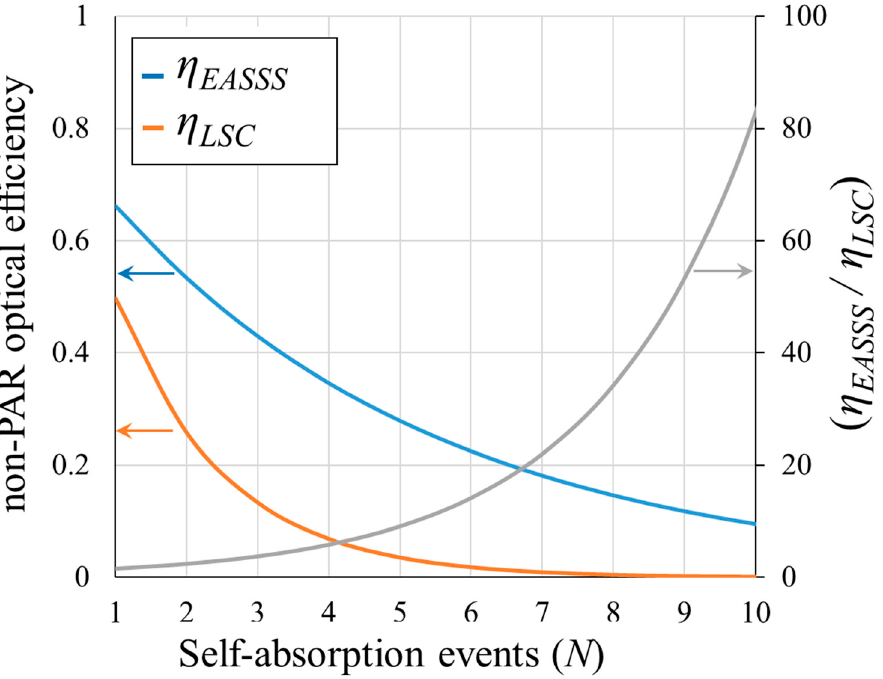
Figure 12. Optical efficiencies for both a conventional LSC and the EASSS panel with c/a = 0.91, c = 1.25 cm and O = 0.1 cm, and their efficiency ratio ( η EASSS / η LSC ) as a function of self-absorption events ( N ).